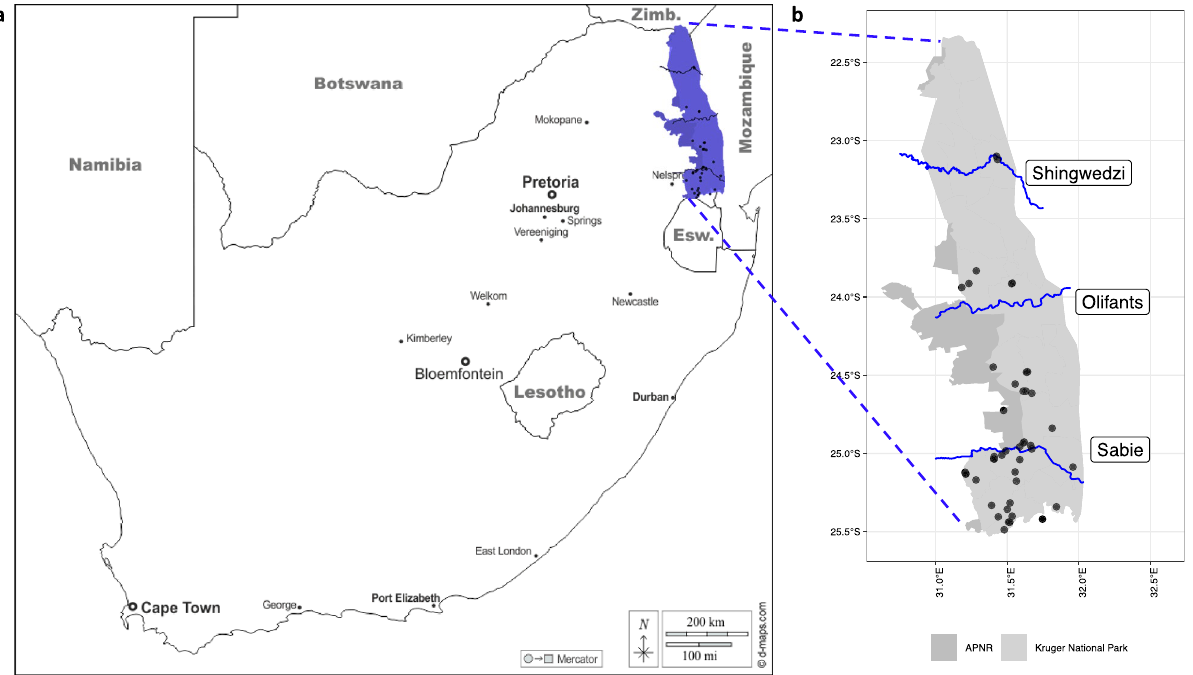
Figure 7. A map of South Africa ( a ), and the Kruger National Park (KNP) (21,353 km 2 ) and Associated Private Nature Reserves (APNR) ( b ) with 71 African wild dog ( Lycaon pictus ) sampling locations (black dots). African wild dogs are widely distributed in KNP 85 , and the Sabie, Olifants, and Shingwedzi Rivers serve as natural geographical barriers and were used to classify the sampling locations into three groups. A single black dot may represent a sampling location for multiple African wild dogs (Supplementary Table 2). The figure of KNP was generated in R 97 and the South African map was obtained from d-maps.com with permission and